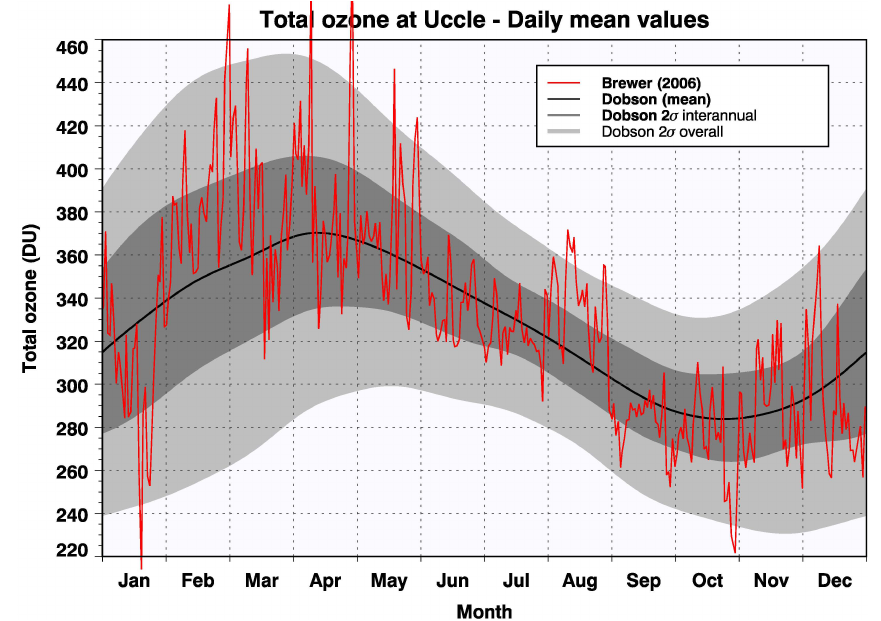
Fig. 1. Total ozone column measured at Uccle; the black line is the mean of all Dobson measurements since 1971, the light and dark grey- shaded area represent the 95%-percentile-bound (or 2 σ error) of the overall and the interannual Dobson time-series variability, respectively (see also text). The daily averages of 2006 measured by Brewer No. 16 are given in